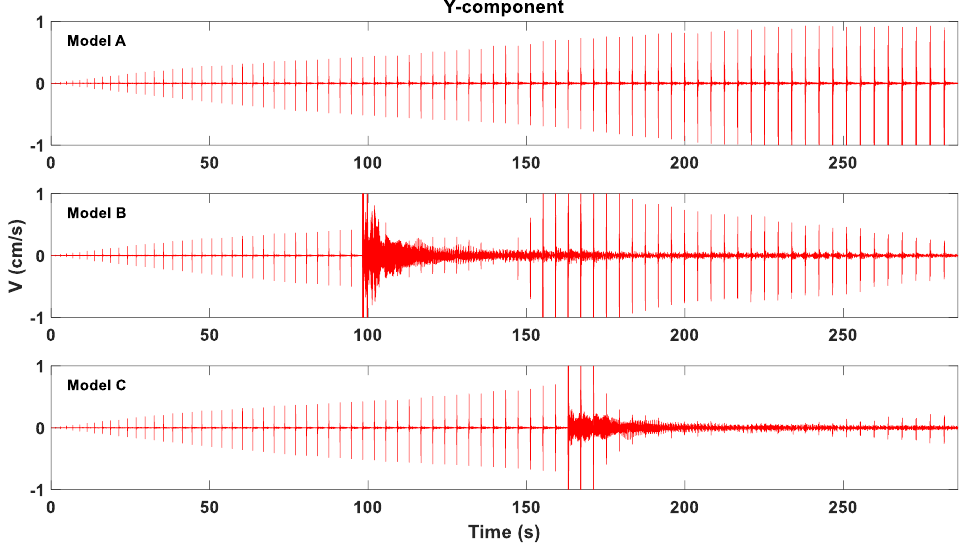
Figure 8—The y-component of the induced microseismicity during hydraulic fracturing. The seismic signals are obtained from the lower first receiver, whose location is shown in Figure